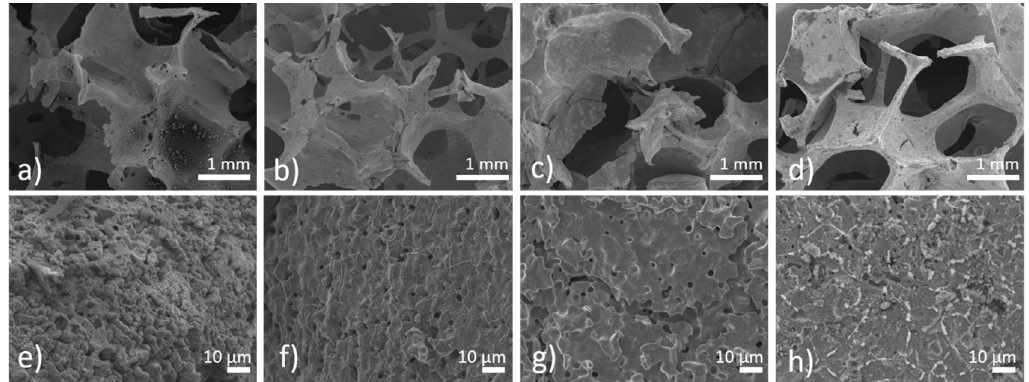
Figure 8. The SEM micrographs of the (a , e ) Fe; ( b , f ) Fe-PEI1; ( c , g ) Fe-PEI2; and ( d , h ) Fe-PEI3 samples after 4 weeks of corrosion in the Hanks´ solution at 37 °C.